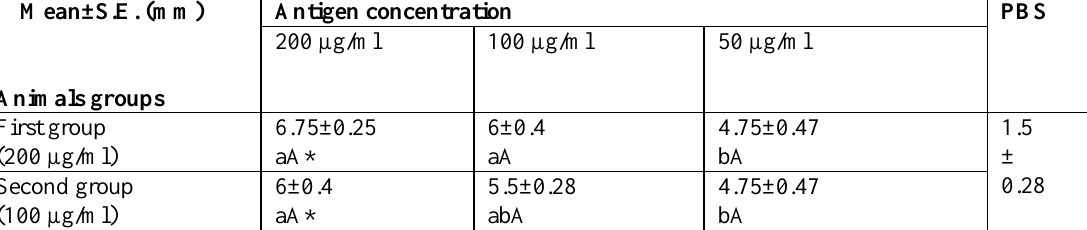
Table 1: Erythema of delayed type hypersensitivity in the immunized rabbits with Proteus vulganis fimbriae antigen after 24 hours.